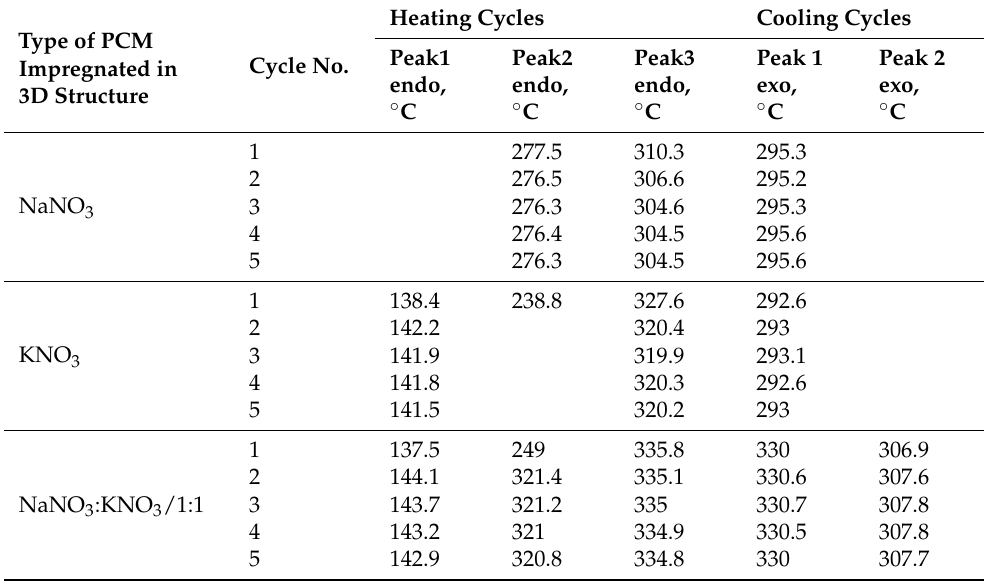
Table 5. Main peaks observed during the heating-cooling thermal cycles of the impregnated 3D